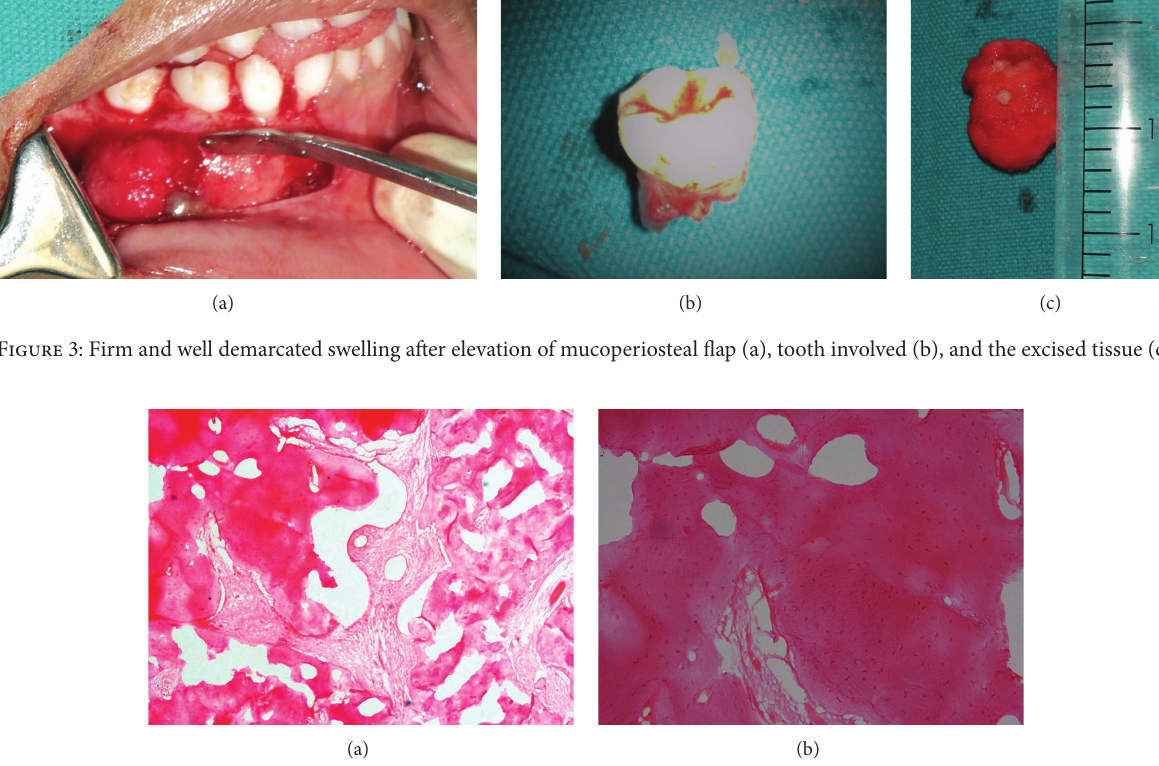
Figure 4: Showing irregular trabeculae of mineralized tissue interspread with fibrovascular connective tissue under 10x magnification (a) and 40x magnifications (b).